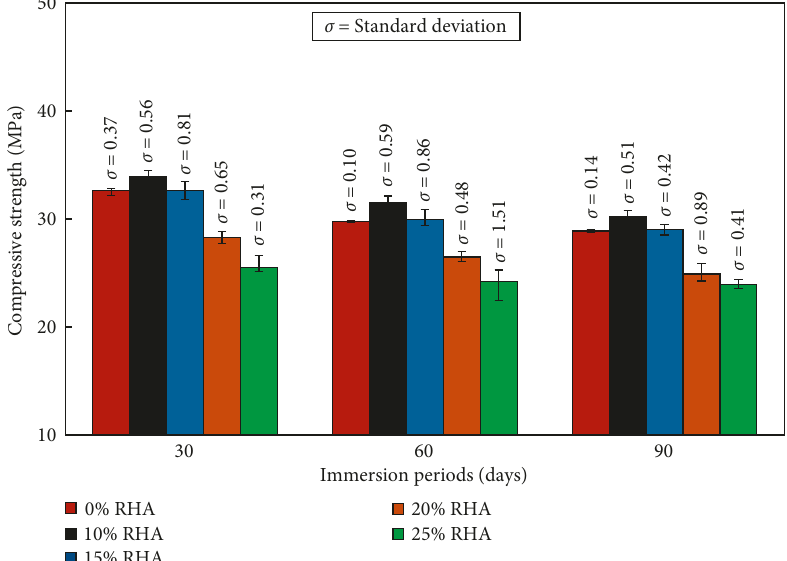
Figure 8: Compressive strength of RBAC immersed in Na